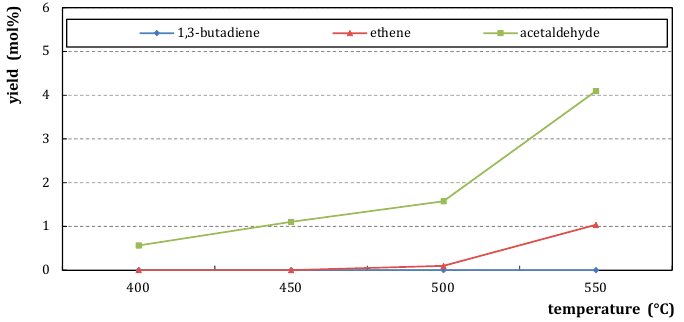
Figure A1. Temperature-programmed ammonia desorption (NH 3 -TPD) profiles of M1 (pure), SiO 2 (pure), and binary M1/SiO 2 catalyst samples with various compositions.